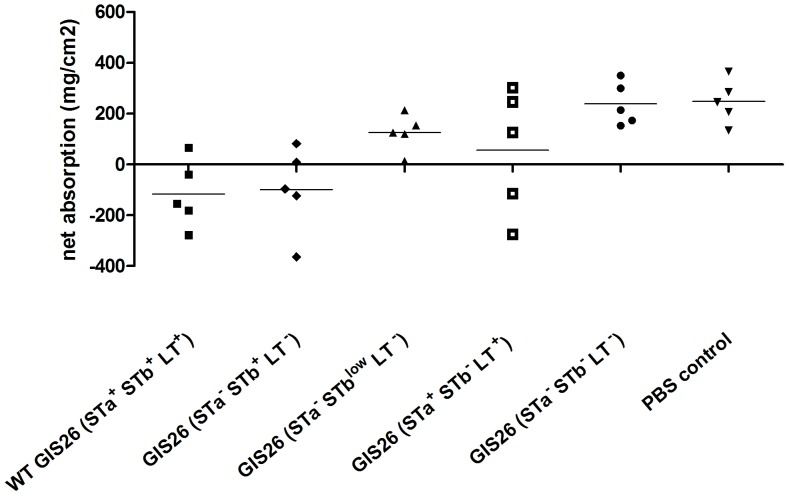
Effect of STb deletion in GIS26 ETEC strain on net fluid absorption (mg/cm2) in 4 h-infected jejunal segments.Individual data per piglet and the mean from 5 individual experiments are presented.